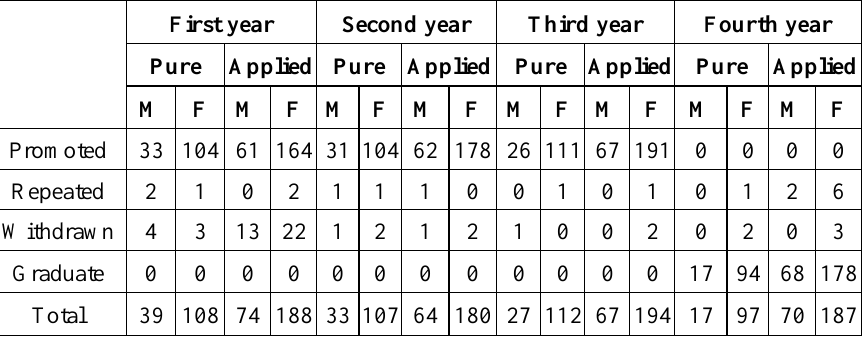
Table 2. The frequency tables of the data.